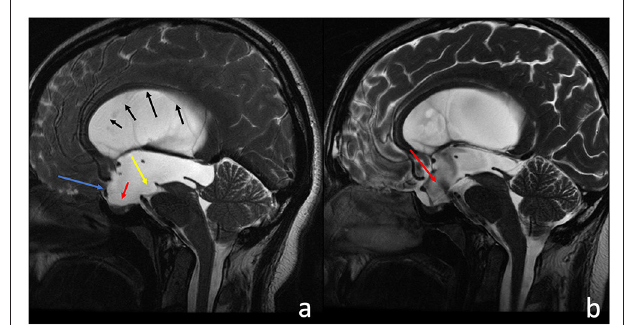
FIGURE 1 | Sagittal T2-w 3D-FIESTA acquisition of a 38-year-old male before (a) and after (b) third ventriculostomy. (a) The third ventricle and the lamina terminalis are concave ( a , blue arrow), the sella turcica is empty ( a , red arrow), and there is an evident compressive effect exerted on the brain stem and the ambiens cistern ( a , yellow arrow). The corpus callosum appears thinned (black sequential arrows), and subarachnoid spaces have a low representation. After the third ventriculostomy (b) , there are evident flow artifacts at the floor of the III ventricle ( a , red arrow). All previous neuroradiological findings clearly improved.